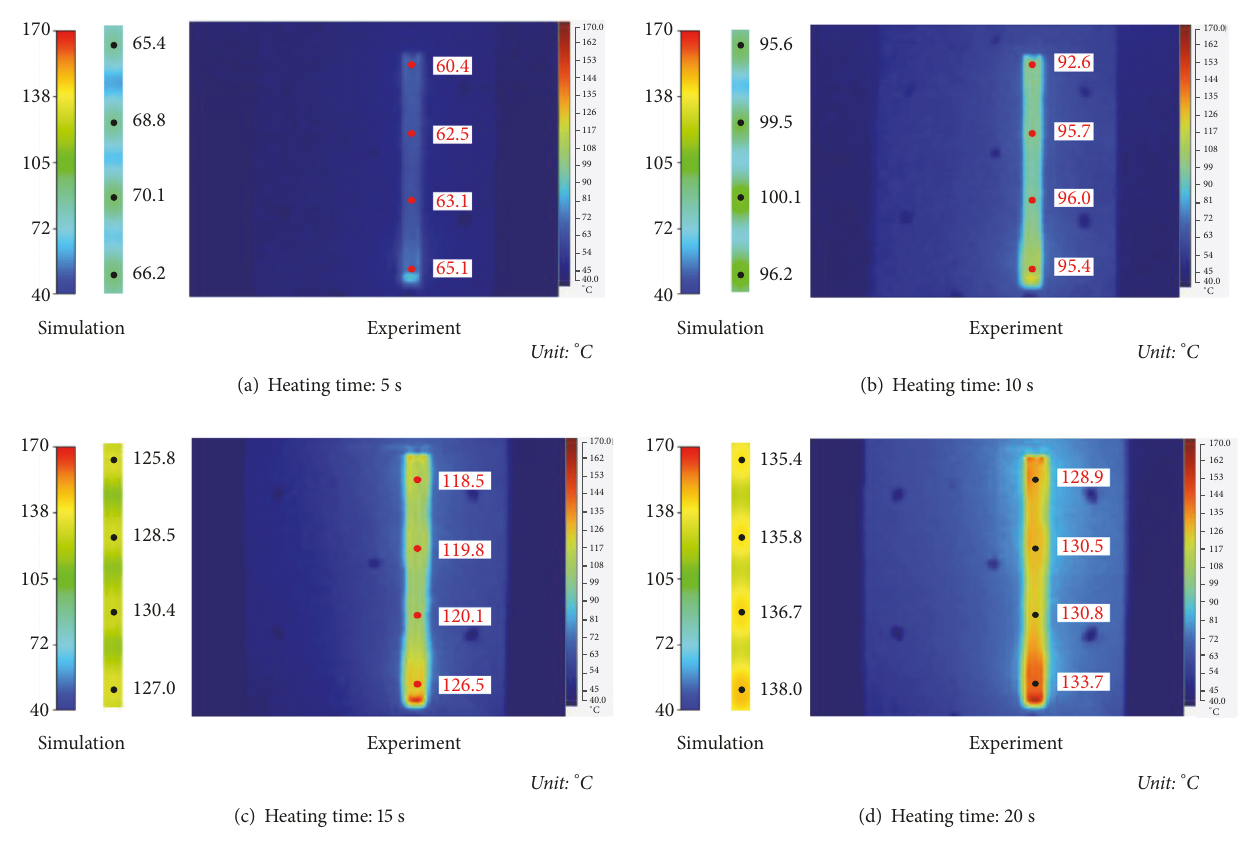
Figure 14: Temperature distribution of the melt flow mold at the beginning of melt filling step.